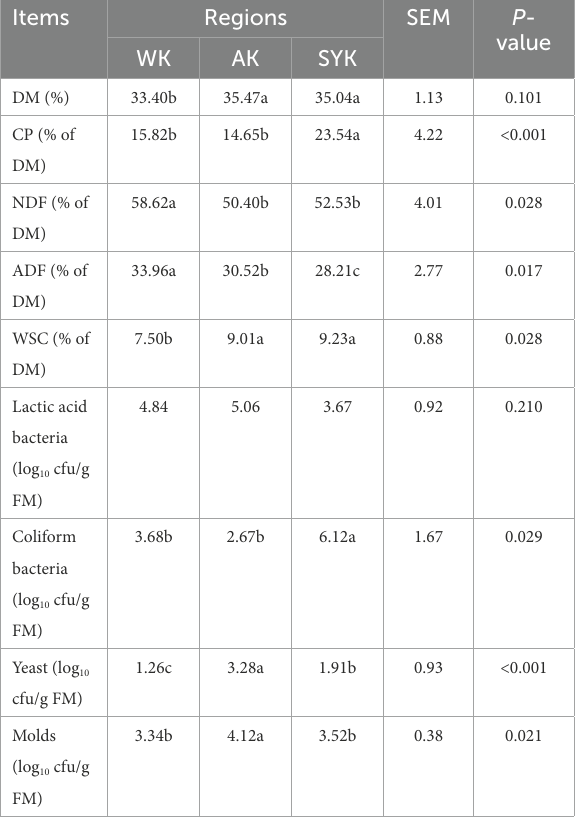
TABLE 2 Chemical and microbial compositions of fresh